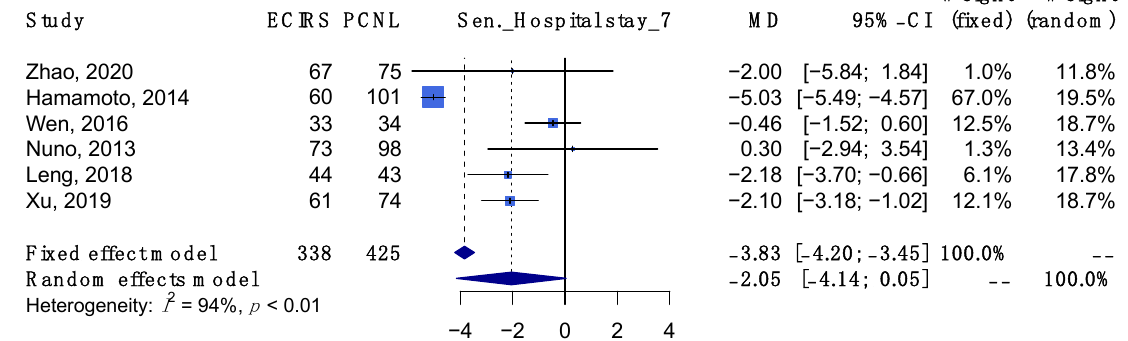
Figure A27. Sensitivity analysis of outcome regarding hospital stay. ([17–20,22,23])